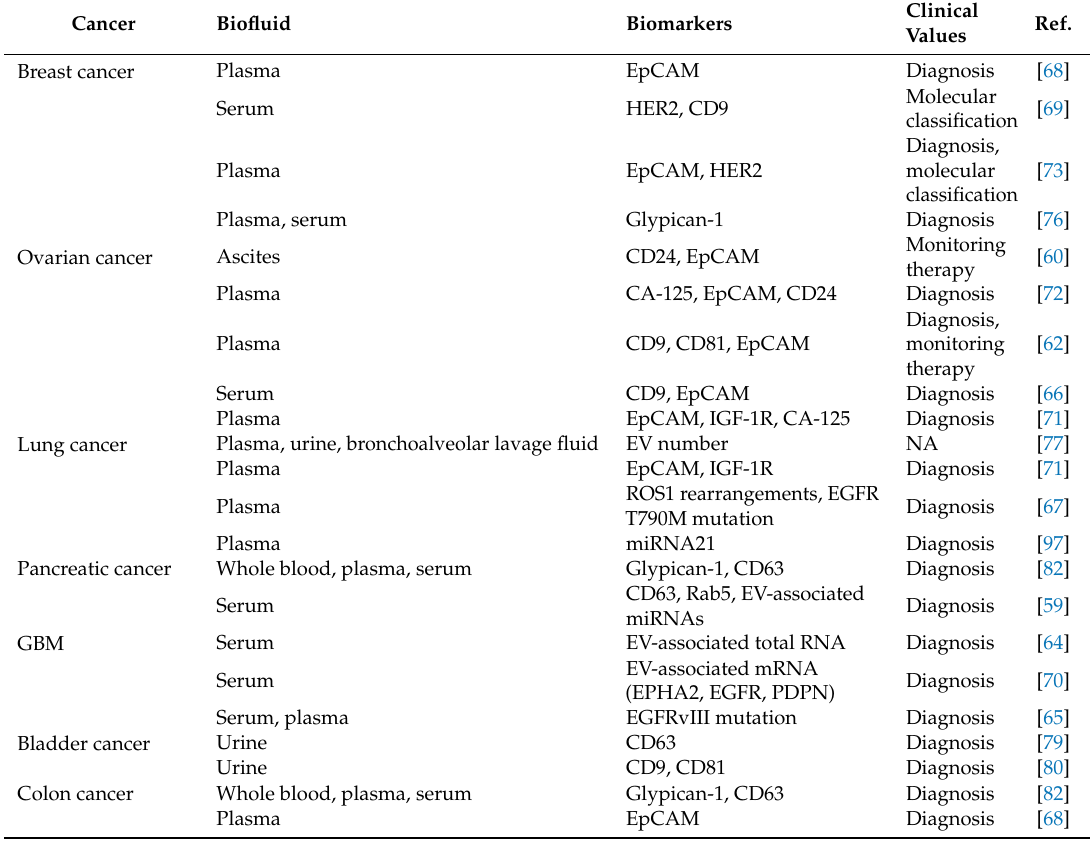
Table 2. Clinical applications of microfluidic technique on cancer liquid biopsy. NA–not available.